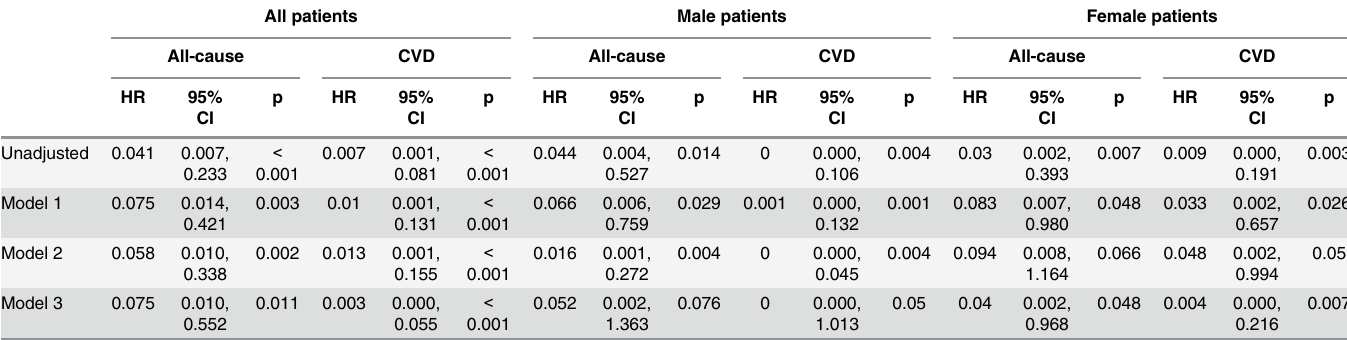
Abbreviations: CVD- cardiovascular disease, HR- hazard ratio, CI- con fi dence interval Model 1 was adjusted for age and gender. Model 2 was adjusted for Model 1+ DM, MAP, urine output, Net UF, rGFR, creatinine clearance and sodium. Model 3 was adjusted for Model 2+malnutrition (body mass index, serum albumin, hemoglobin level and TC, TG) and mineral and bone disorder-related factors (levels of serum calcium, phosphate, intact parathyroid hormone, prescription of Calcium carbonate, active vitamin D analogue).